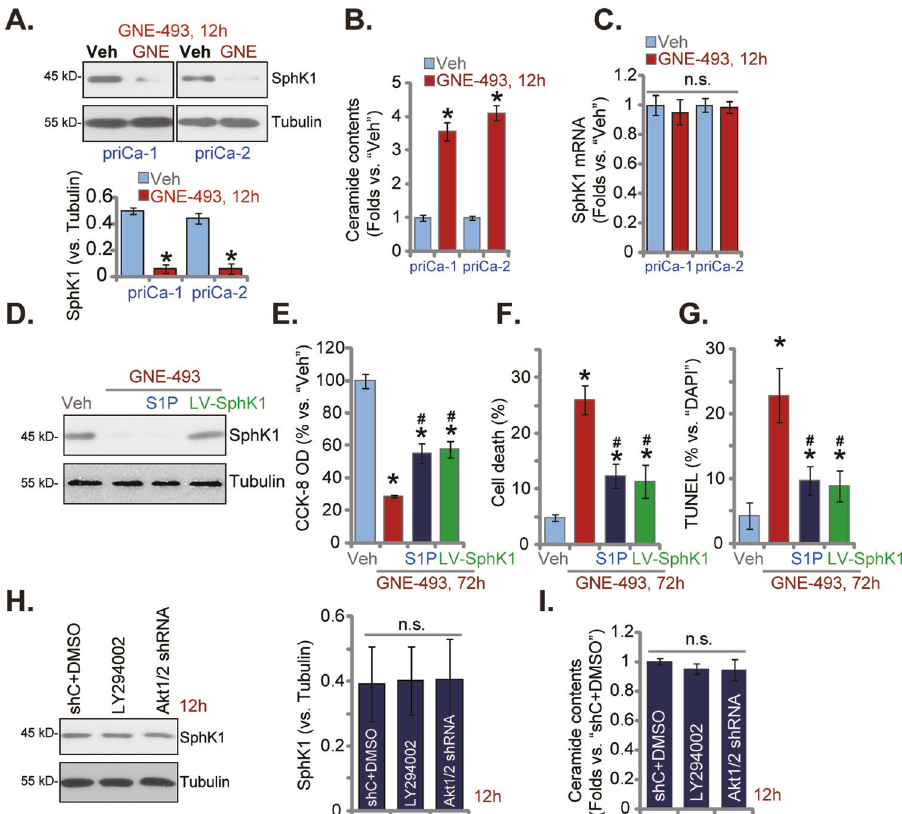
Fig. 5 GNE-493 downregulates SphK1 protein and induces ceramide accumulation in prostate cancer cells. The primary prostate cancer cells, priCa-1 or priCa-2, were stimulated with GNE-493 (250 nM) or the vehicle control (0.25% DMSO, “ Veh ” ); cells were further cultivated for an additional 12 h, the SphK1 protein expression ( A ), the ceramide contents ( B ) and the SphK1 mRNA expression ( C ) were tested. priCa-1 cells were infected with SphK1-expressing lentiviral particles (LV-SphK1, for 72 h) or pretreated with sphingosine 1-phosphate (S1P, 10 μ M, 2 h), followed by GNE-493 (250 nM) treatment, control cells were treated with vehicle control. Cells were further cultivated for 72 h, cell viability (by testing the CCK-8 OD, E ), cell death (by measuring the Trypan blue-positive cell percentage, F ) and apoptosis (by examining the TUNEL- positive nuclei percentage, G ) were tested. priCa-1 cells were infected with Akt1/2 shRNA lentiviral particles (Akt1/2 shRNA, for 72 h) or treated with LY294002 (1 μ M), the control cells were treated with the control shRNA lentiviral particles ( “ shC ” ) plus DMSO (0.1%); Cells were cultivated for additional 12 h, levels of SphK1 protein ( H ) and ceramide contents ( I ) were tested. * P < 0.05 versus “ Veh ” group. # P < 0.05 versus “ GNE-493 ” only treatment. “ n.s. ” stands for non-statistical